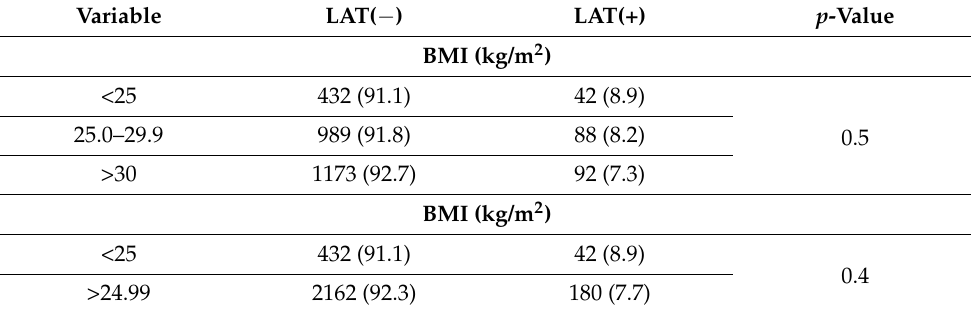
Table 3. Prevalence of left atrial thrombus in relation to